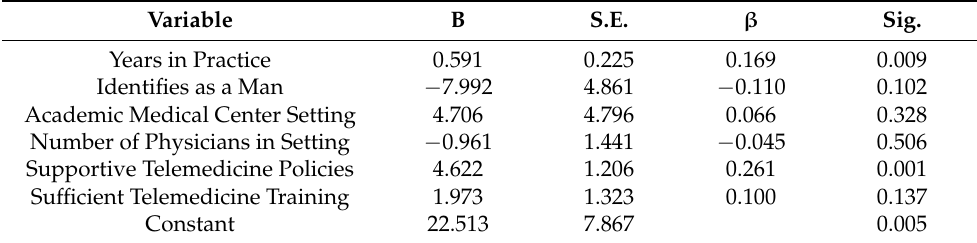
Table 4. Multiple regression of demographic, training, and organizational policy